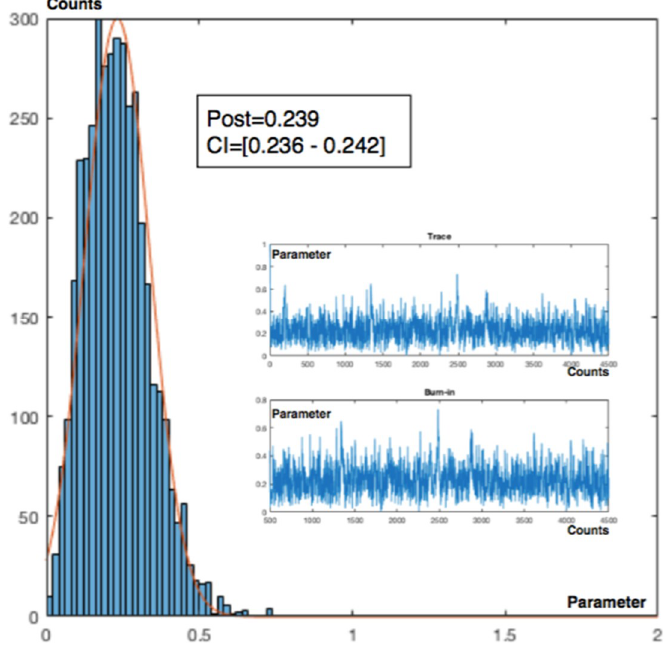
Figure 24. Interval 7. Sampling n = 4500, burn = 500; 10 cycles. AR = 57%.